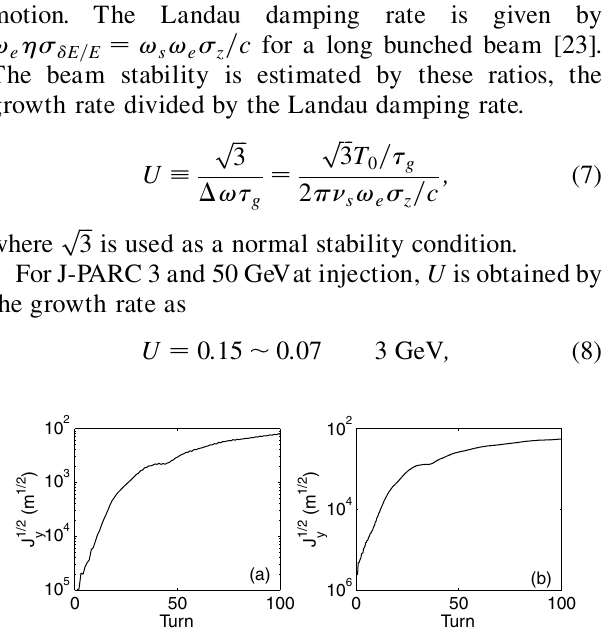
FIG. 7. Vertical dipole moments for J-PARC 3 GeVand 50 GeV rings at injection. The right-left correspond to the head-tail of a bunch, respectively. Pictures (a) and (b) are obtained for 3 and 50 GeV,